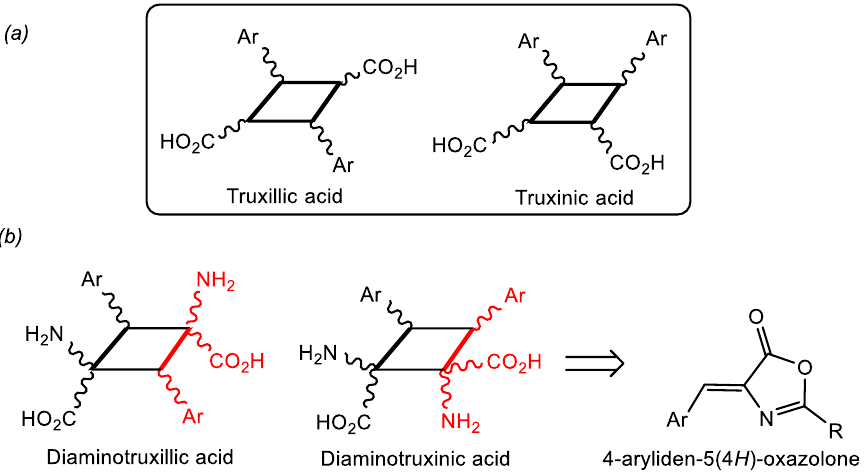
Figure 1. Schematic representation of ( a ) truxillic and truxinic acids; ( b ) unnatural 1,3-diaminotruxillic and 1,2-diaminotruxinic amino acids, showing their simplest retrosynthetic route. Closely related to the truxillic and truxinic acids are the unnatural bis-amino acids 1,3-diaminotruxillic and 1,2-diaminotruxinic derivatives (Figure 1b), which also show antinociceptive activity, and, moreover, are promising substrates in the treatment of diabetes type-II because they are the only non-peptidic agonists of the Glucagon Like-Peptide-1 (GLP-1) receptor [26–28]. The basic scaffold of 1,3-diaminotruxillic and 1,2-diaminotruxinic amino acids is a cyclobutane; therefore, the simplest synthetic approximation for their preparation could be the [2+2]-photocycloaddition of two olefins [29], more specifically, two 4-aryliden-5(4 H )-oxazolones (Figure 1b). Despite its apparent simplicity, this syn-